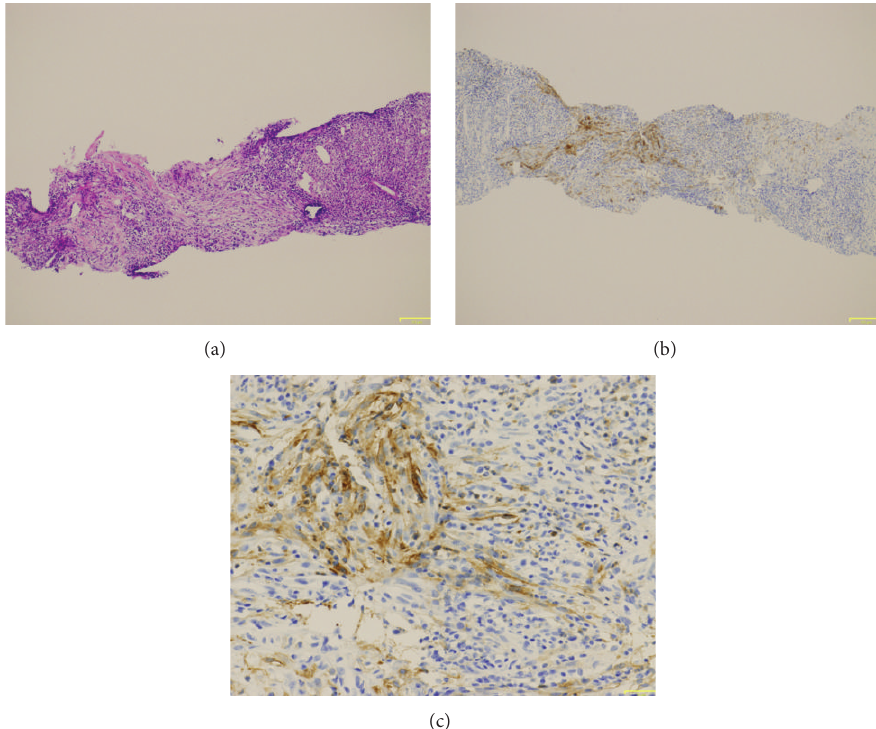
Figure 5: Pathological finding. (a) Liver biopsy of the hepatic mass shows extensive infiltration of lymphocytes and neutrophils, and fibrosis (hematoxylin and eosin staining, × 100). ((b) and (c)) Immunohistochemical staining shows CD10-positive spindle shaped myofibroblasts in a background of collagenous and fibrous tissue ((b): × 100, (c): ×